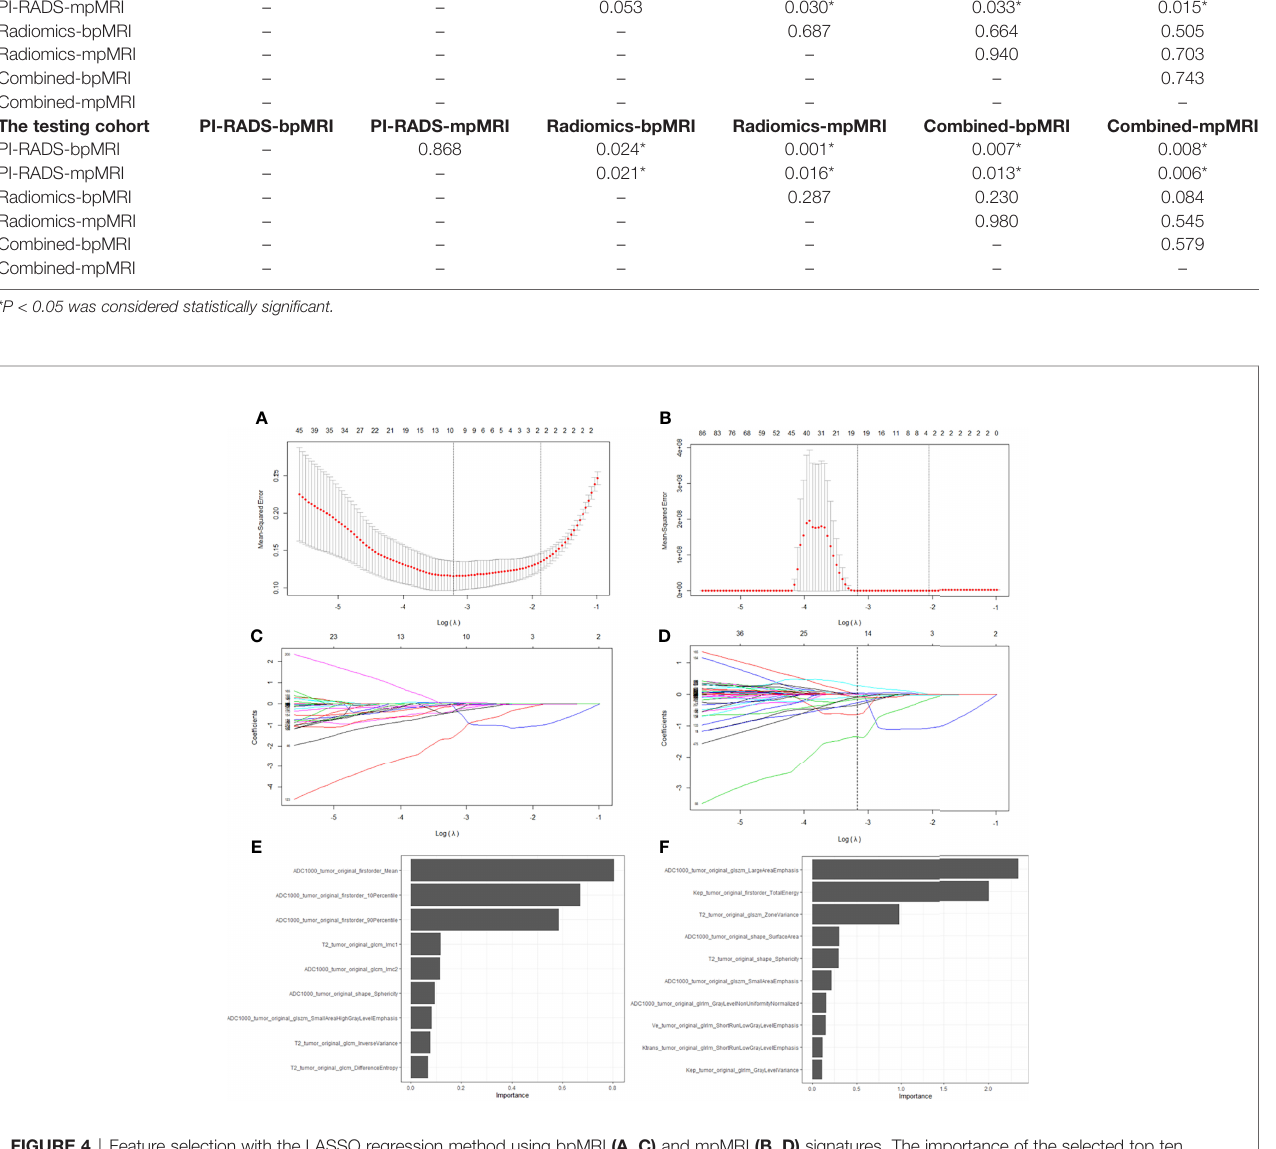
FIGURE 4 | Feature selection with the LASSO regression method using bpMRI (A, C) and mpMRI (B, D) signatures. The importance of the selected top ten features in bpMRI and mpMRI images were shown in (E, F) ,